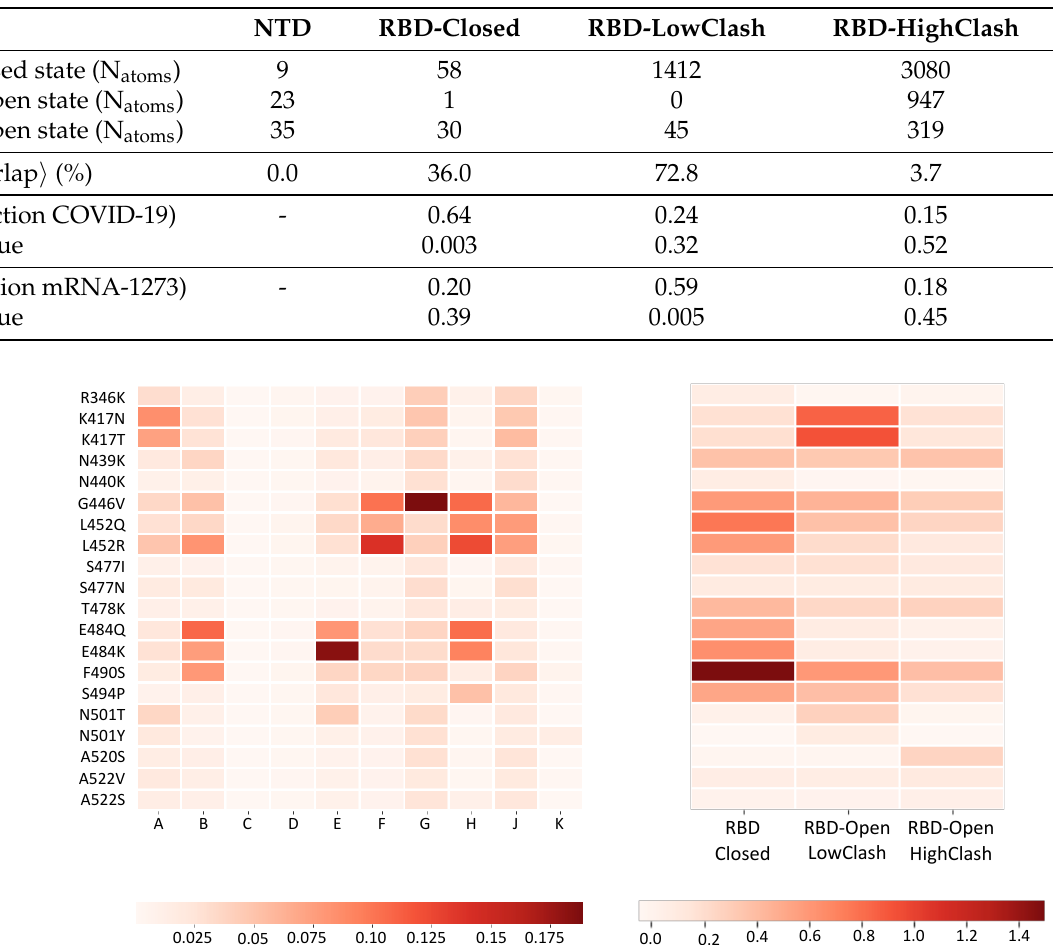
Table 1. Average characteristics of the four classes of nAbs computed from the 83 complexes of the D nAb-spike dataset. The steric clash scores (in number of clashing atom pairs N atoms ) are given for the nAb-spike protein complexes in closed, 1-open and 3-open trimer conformations. The angiotensin- converting enzyme 2 (ACE2) overlap is computed as the percentage of RBD residues that bind ACE2 and overlap with a given epitope, on average for each class of nAbs. The Pearson correlation coefficient r is computed between the predicted change in binding affinity upon mutation ( ∆∆ G b ) (see Section 2.4) on the set of the 20 most frequent receptor binding domain (RBD) variants observed in the circulating viral strains [25] and averaged over the nAb complexes of the different classes, and the measured variant escape fractions from 10 COVID-19 patient plasma [26] and from 23 healthy individuals vaccinated with mRNA-1273 [27].